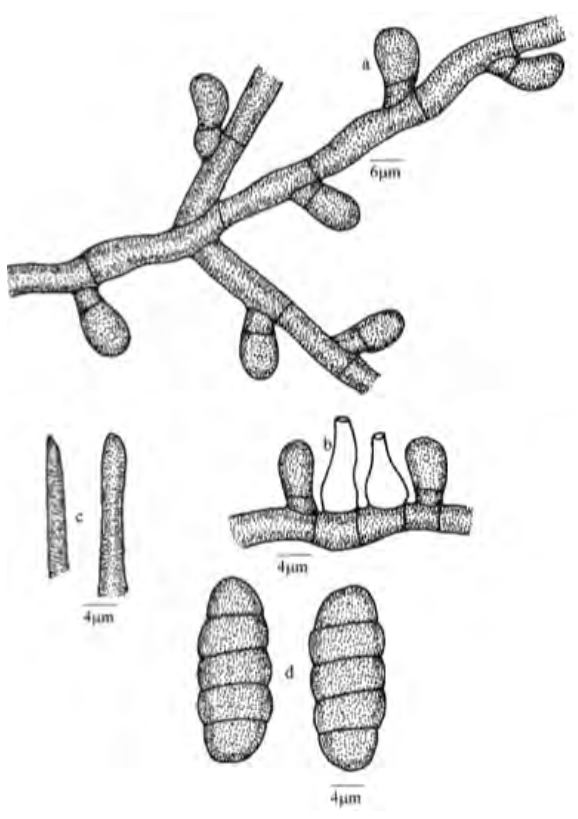
Figure 65. Meliola clerodendricola a – Appressorium, b – Phialide, c - Apical portion of mycelial